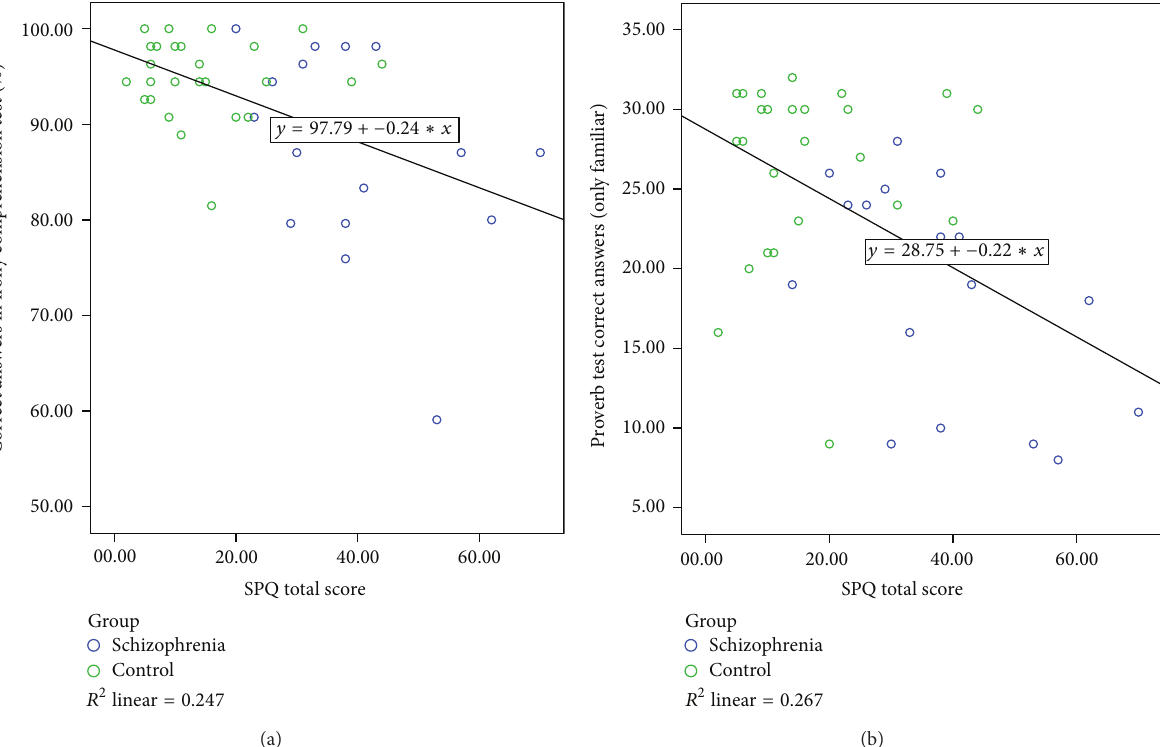
Figure 3: Correlation between performance in the (a) irony comprehension test and (b) proverb comprehension test and schizotypal personality